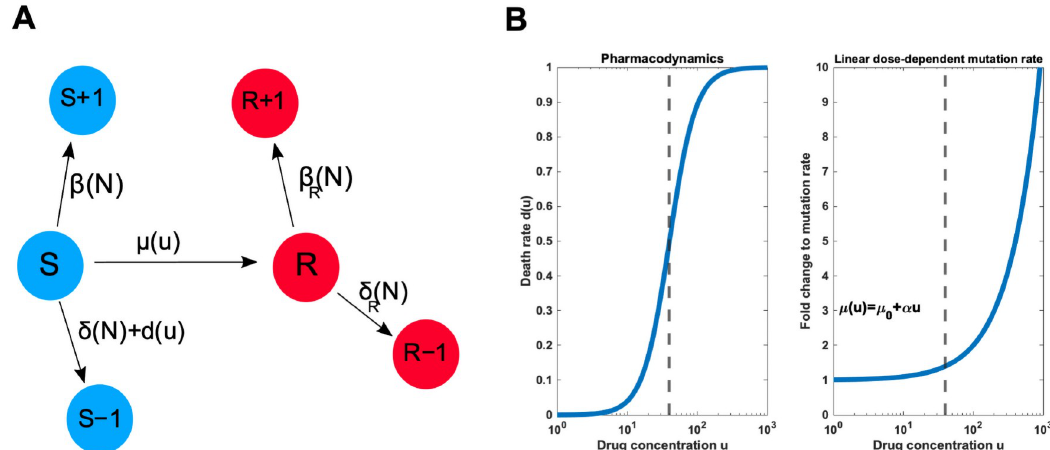
Fig 6. Schematic illustration of the model. A A minimal model for drug resistance distinguishes sensitive ( S ) and resistant ( R ) cells, which follow their own birth-death processes. A treatment can be used to target sensitive cells, but sensitive cells can become resistant via rescue mutations. B Specification of dose-dependent death and mutation rates. We analyse a Hill-type pharmacondynamics and linear dose-dependent mutation rate, but any pharmacodynamics with finite control leverage and monotonically increasing mutation rate will lead to qualitatively similar results reported here. The dashed lines denote the growth inhibitory drug concentration.